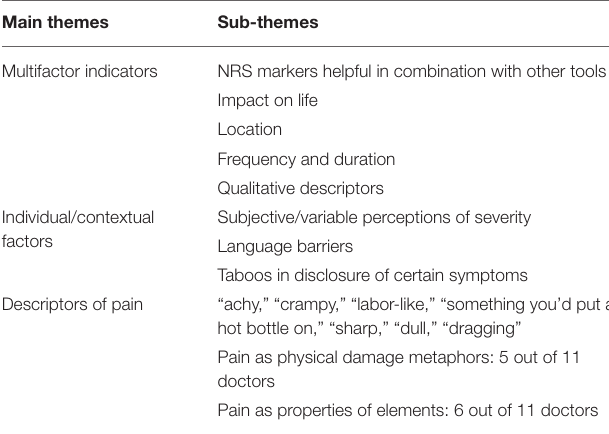
TABLE 1 | GPs demographic information.